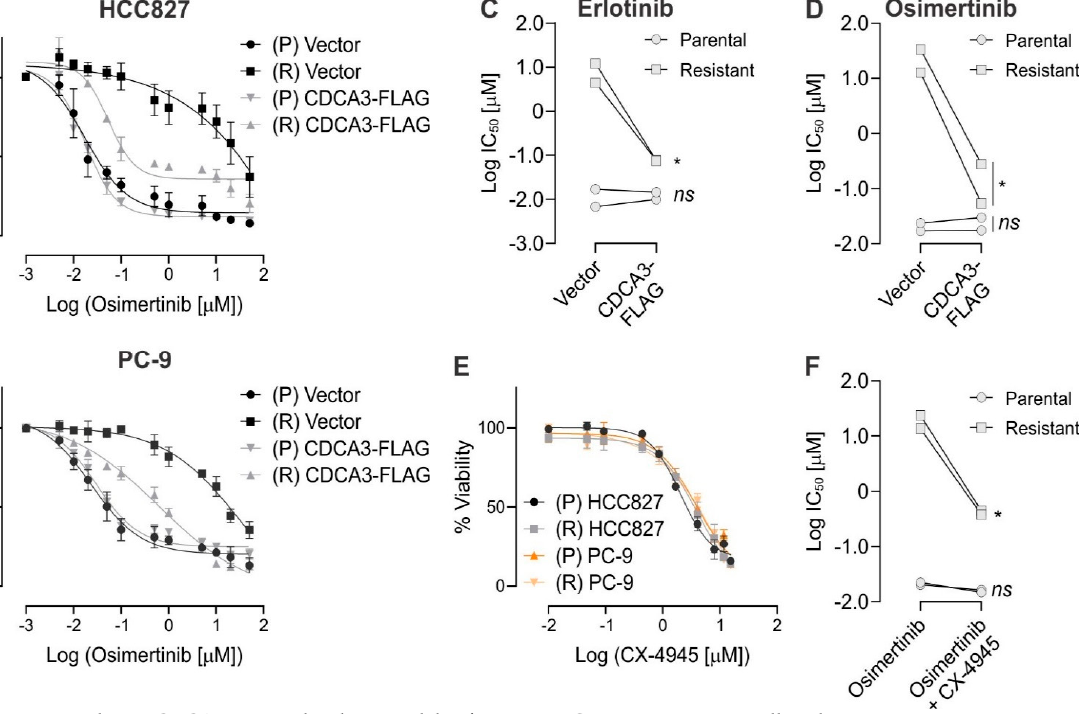
Figure 5. Upregulating CDCA3 protein levels in models of isogenic EGFR TKI resistance cells enhances TKI sensitivity. ( A , B ) Dose–response curves for vector transfected or ectopic CDCA3-FLAG overexpression in isogenic parental and resistant ( A ) HCC827 and ( B ) PC-9 cells treated with escalating doses of osimertinib for 72 h before assessing cell viability. ( C ) Plot showing erlotinib potency (log IC 50 value) comparing vector transfected and ectopic CDCA3-FLAG overexpression in isogenic parental and TKI-resistant cell lines determined in Figure S2 from four independent experiments. Lines connect respective isogenic parental and resistant cell lines (2-way ANOVA, * p = 0.029, ns = not significant). ( D ) Plot showing osimertinib potency (log IC 50 value) comparing vector transfected and ectopic CDCA3-FLAG overexpression in isogenic parental and TKI-resistant cell lines determined in ( A , B ) from four independent experiments with lines connecting respective isogenic parental and resistant cell lines (2-way ANOVA, * p = 0.0339, ns = not significant). ( E ) Dose–response curves for HCC827 and PC-9 isogenic parental and TKI-resistant cell lines treated with escalating doses of CX-4945. Cells were treated with CX-4945 for 72 h before assessing cell viability. CX-4945 potency values (IC 50 ) were calculated using GraphPad Prism and listed for each cell line. n = 3. ( F ) Plot showing potency (log IC 50 value) of osimertinib alone or in combination with CX-4945 (IC 50 ) comparing isogenic parental and TKI-resistant cell lines from three independent experiments. Lines connect respective isogenic parental and resistant cell lines (2-way ANOVA, * p = 0.0331, ns = not significant).